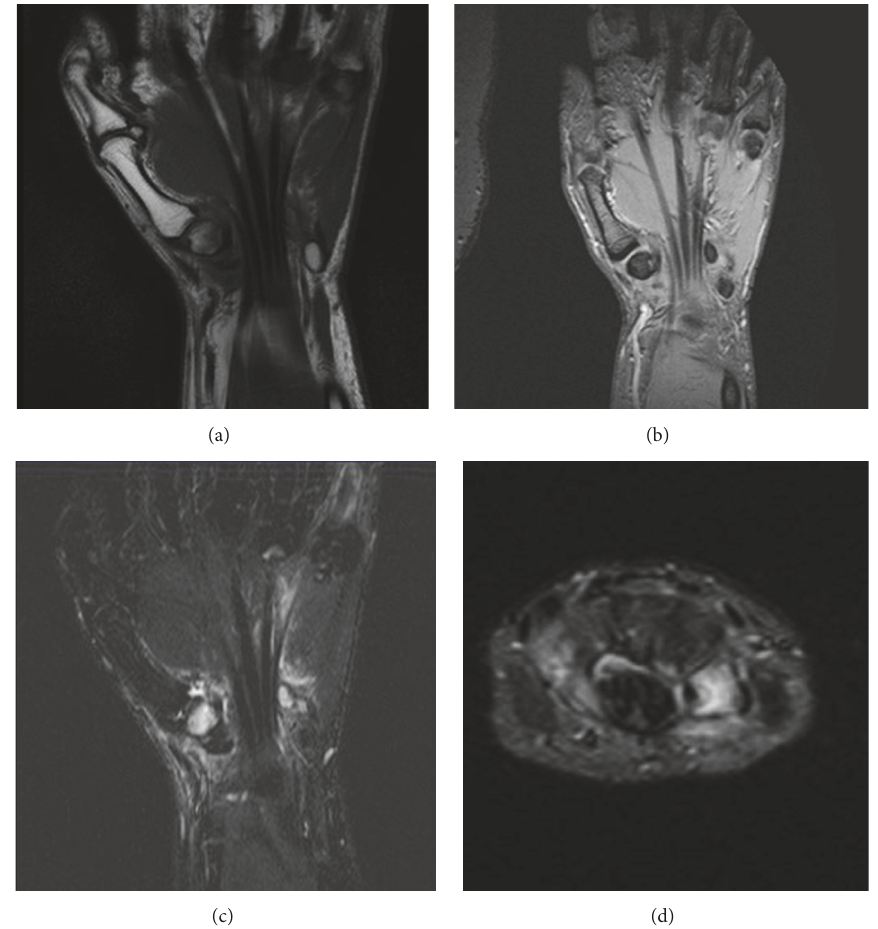
Figure 1: (a) T1-weighted coronal image reveals areas of low signal intensity affecting the trapezium. (b) PD coronal image shows heterogeneous signal intensity with areas of high signal intensity. ((c) and (d)) STIR coronal and axial images reveal increased signal intensity affecting the whole trapezium consistent with hyperemic areas due to repair process and oedema.